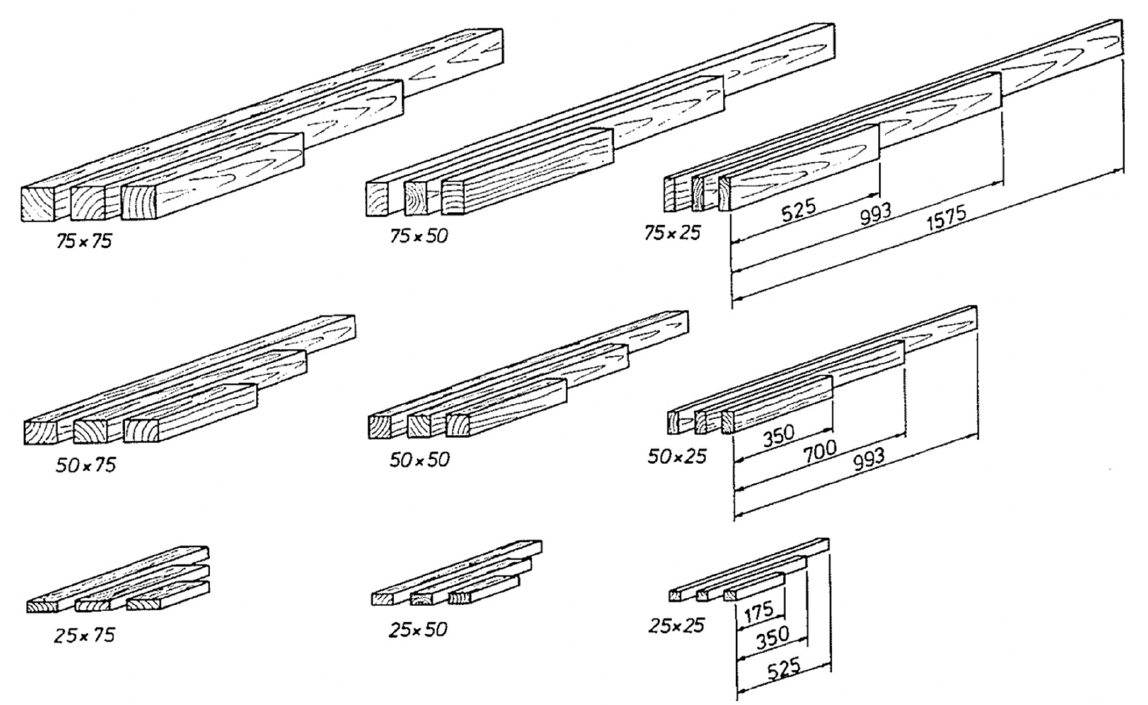
Figure 41. Total of 27 different specimen sizes for investigating length, depth, thickness size effects for spruce, pine, and fir. From [104].